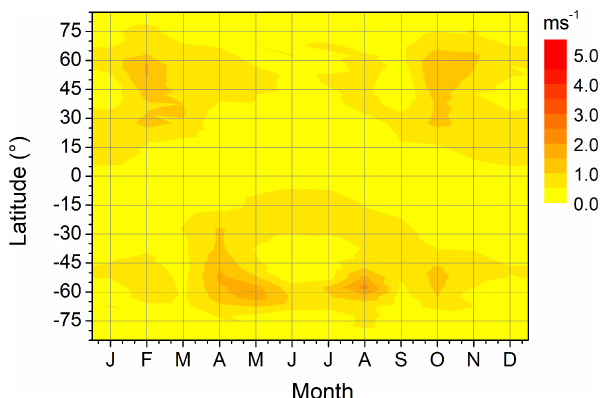
Figure A1. QDT zonal wind amplitudes at 95 . 2km altitude, as modeled by MUAM.